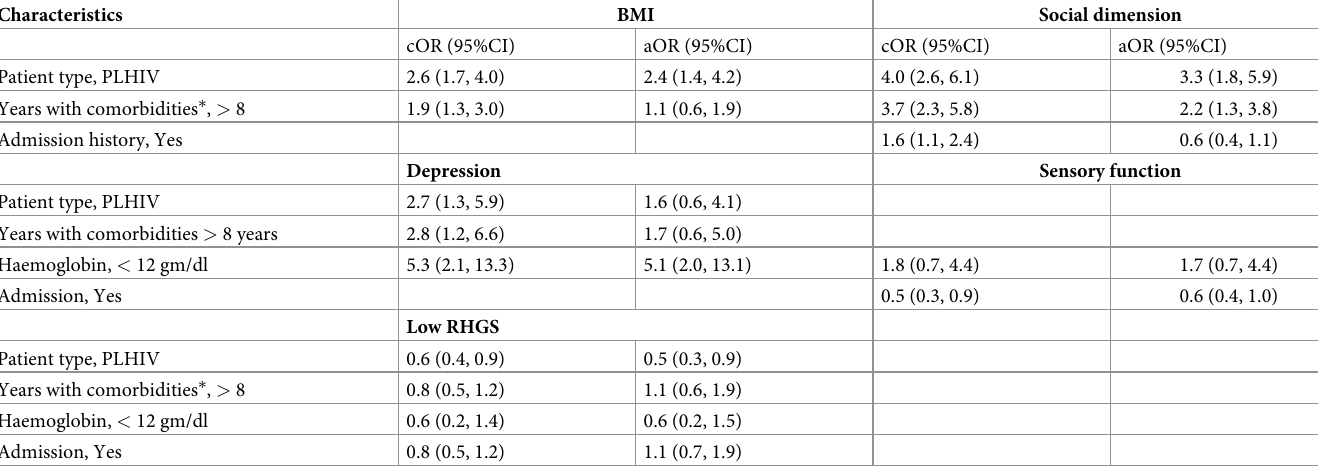
Table 6. Associations between individual components of the B-FIT and clinical characteristics of the study